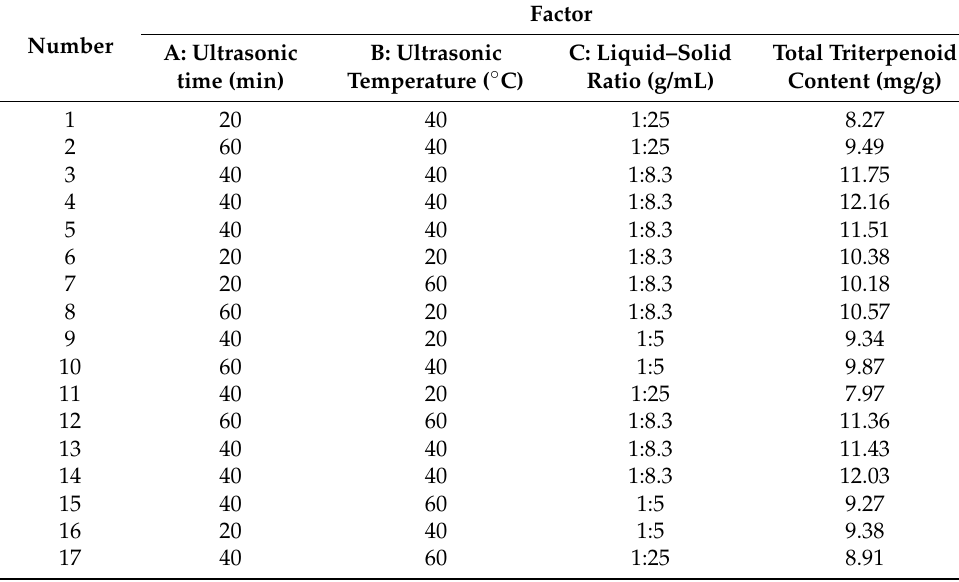
Table 3. Experimental results of response surface methodology (Loquat Pulp).